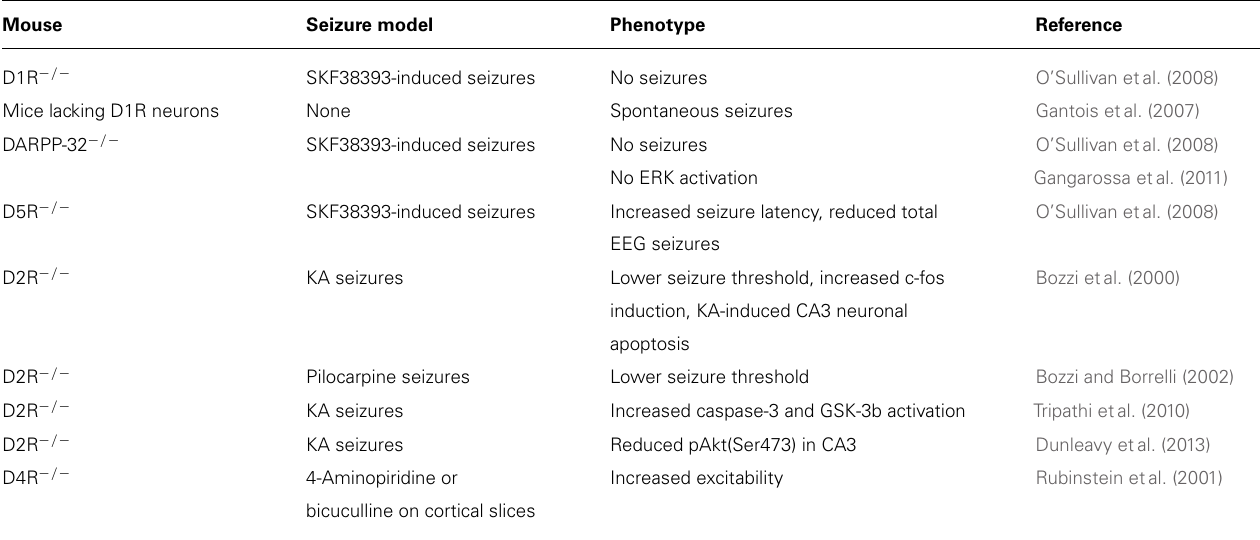
Table 2 | Dopamine signaling in epilepsy: knockout mouse